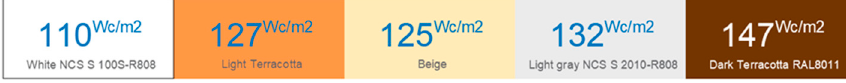
Figure 14. Solar panel performance and color.